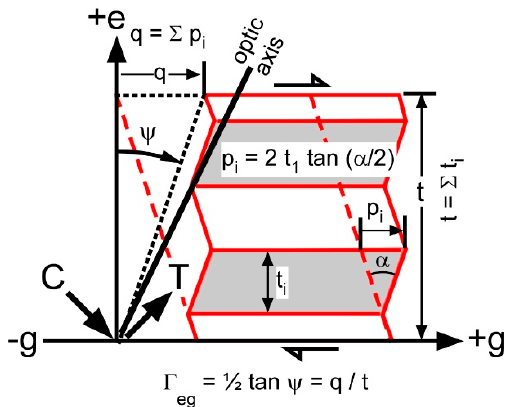
Figure 1. Simple shear strain caused by calcite e-twins (modified from [5]). e is the pole to the twin plane and +g is the glide direction: C = compression axis, T = tension axis, t i = thickness of a twin, p i = offset of boundary caused by a twin, q = total boundary offset due to twinning, α = rotation angle from untwinned to twinned position (38°17 ′ ), ψ = angle of shear, Γ eg = tensor shear strain in the +e and +g coordinate system.